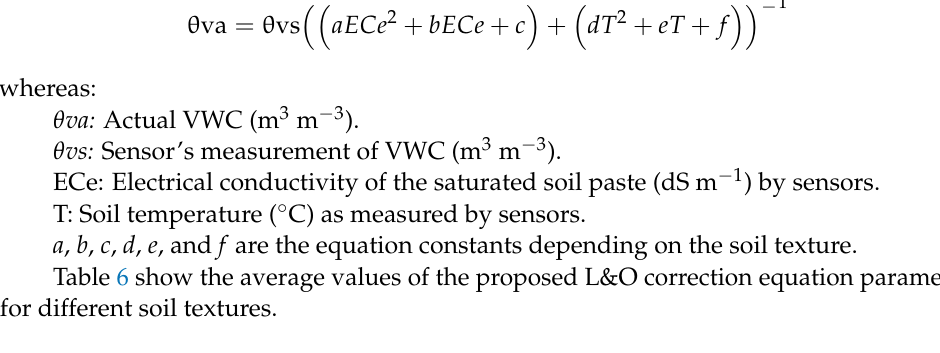
Figure 8. Influence of soil bulk density on sensor measurements in low-salinity (1.4 dS m − 1 ), moderate